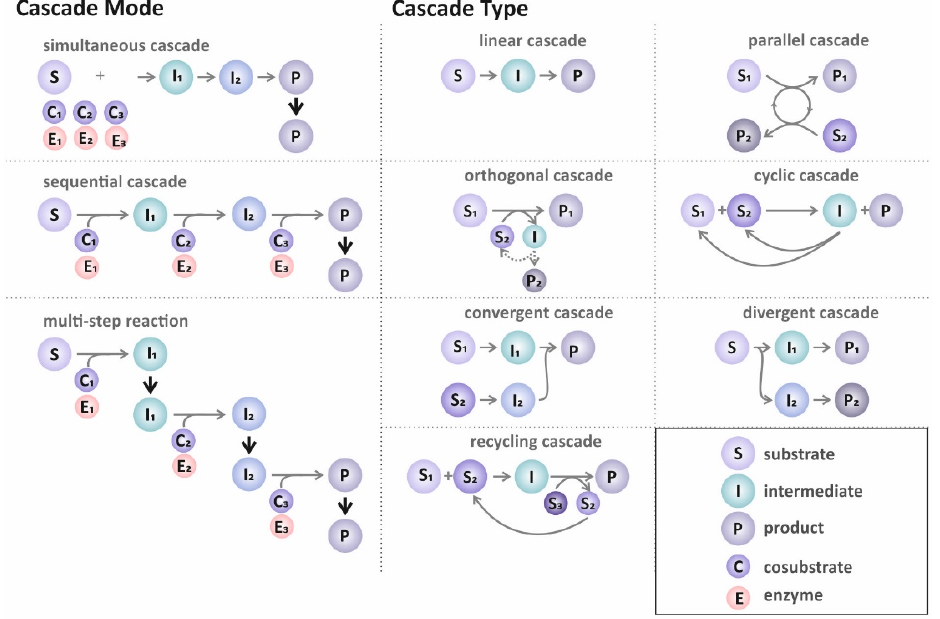
regeneration or with the destructive removal of by-products; cyclic cascade—a combination of substrates is transformed into product and intermediate, while the intermediate is converted back